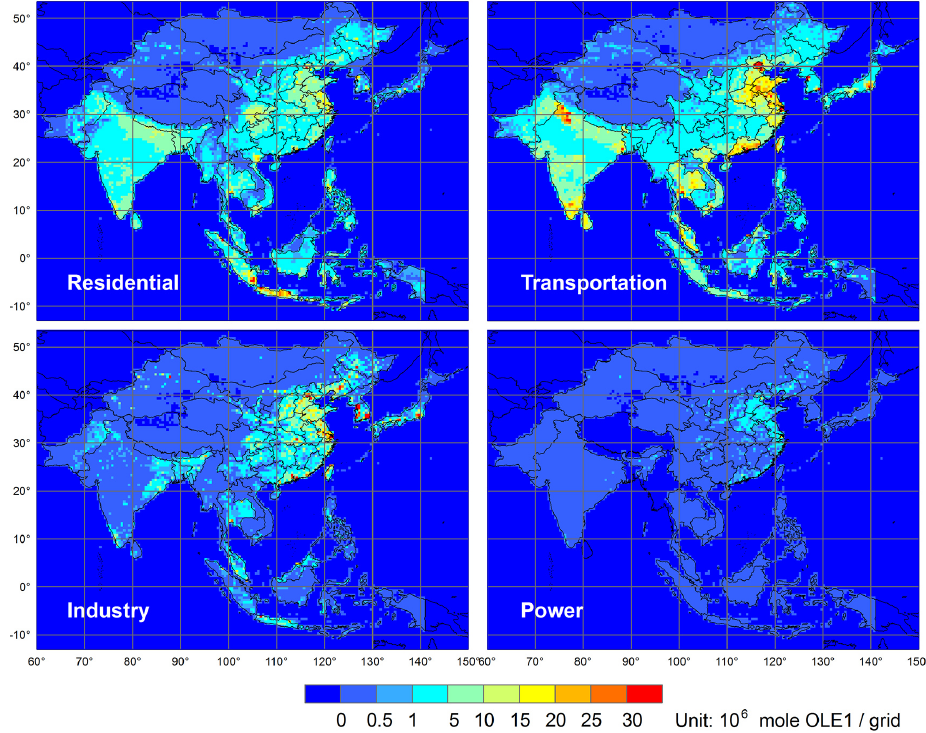
Figure 11. Emission distribution at 30min × 30min resolution of OLE1, SAPRC-99 species.